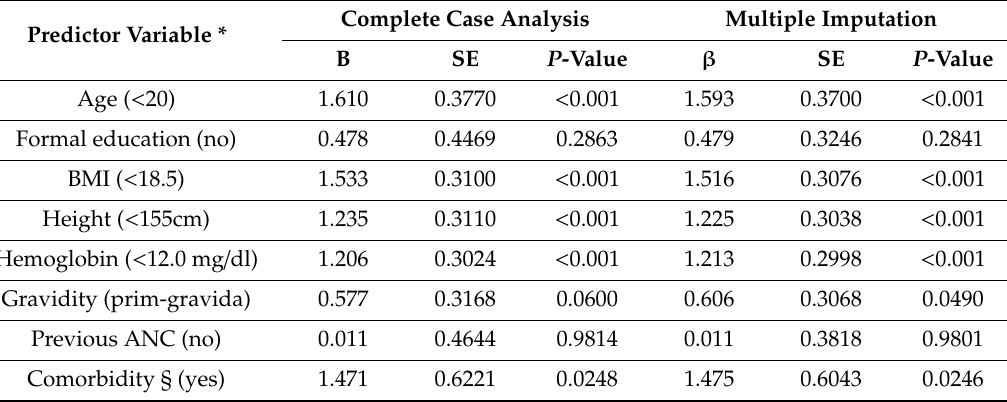
Table A1. Sensitivity analysis of the model to predict low birthweight: Comparison of the regression coe ffi cients, standard errors (SE), and p -values for complete case analysis (CCA) and multiple imputation (MI) for generalized linear mixed model fit by maximum likelihood. (Number of cluster = 10, Standard deviation = 0.06308).